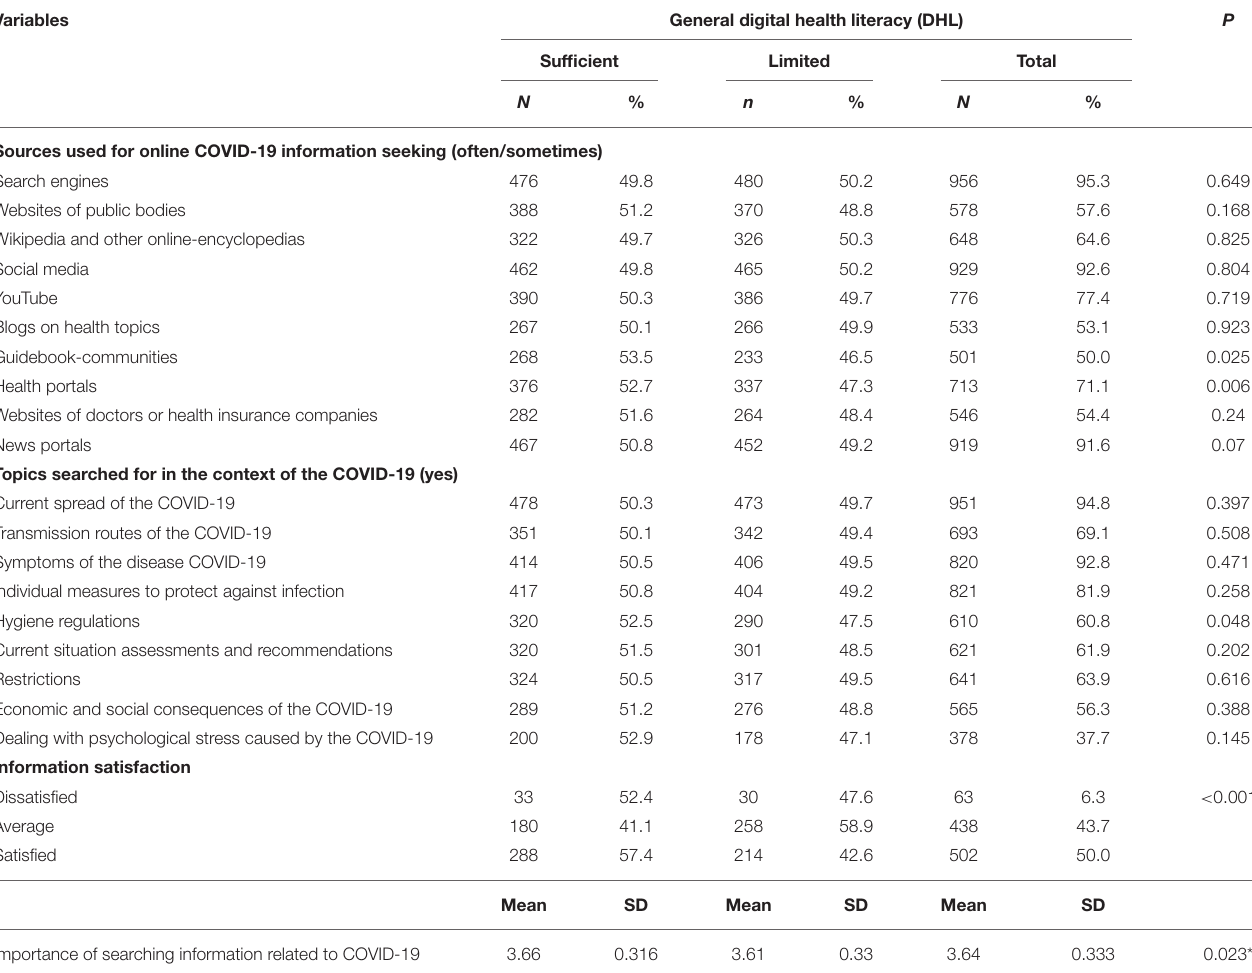
TABLE 2 | COVID-19 related information-seeking behavior and attitude toward COVID-19 related online information searching among Vietnamese university students by DHL. Variables General digital health literacy